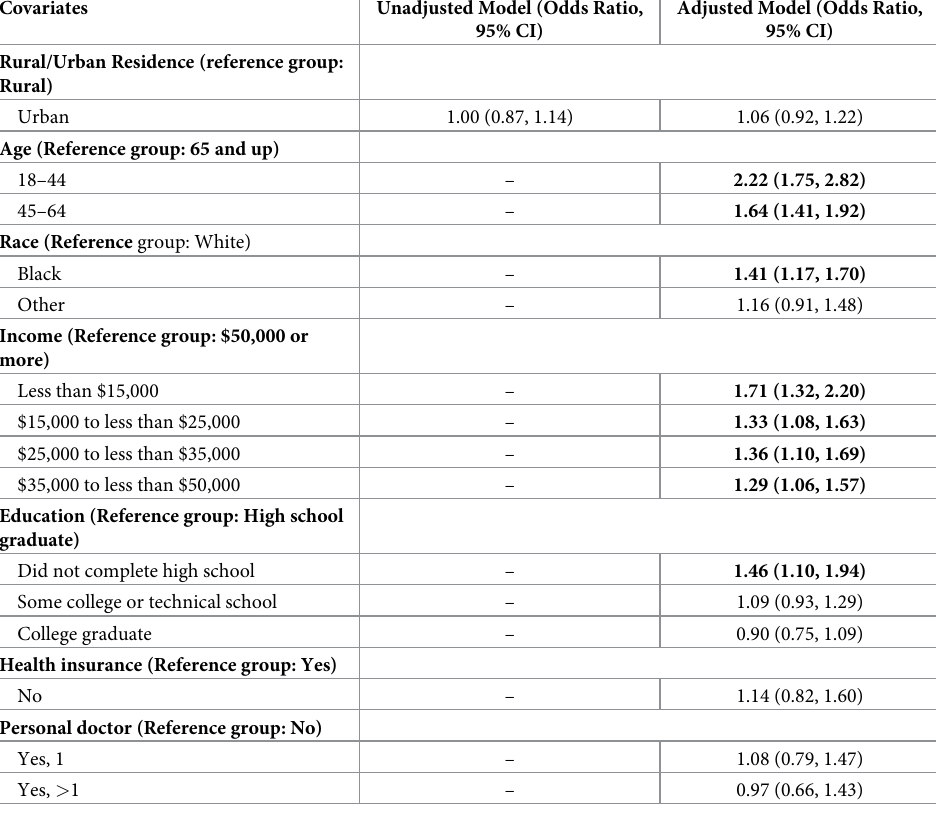
Table 2. Associations between rural/urban residence and short sleep duration among US women with prediabetes in the 2016–2020 Behavioral Risk Factor Surveillance System (BRFSS) surveys 2 .